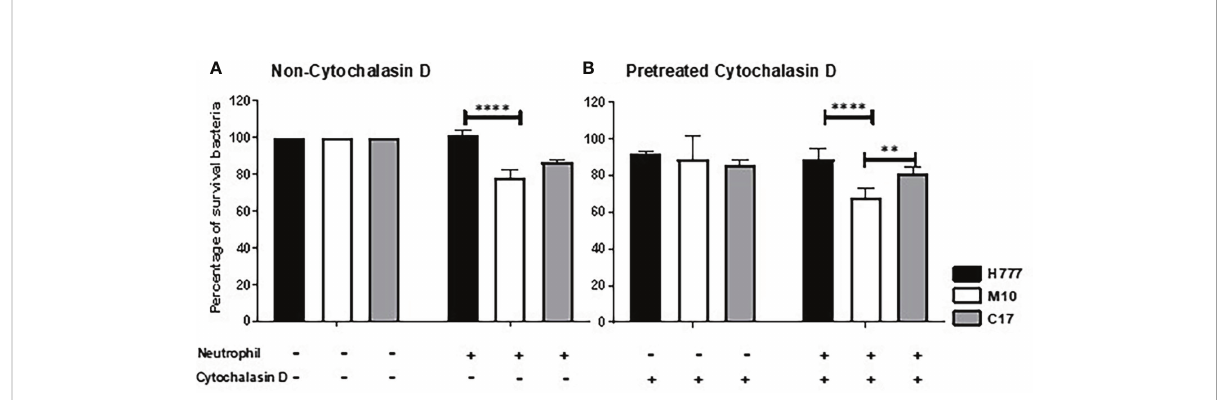
FIGURE 1 Burkholderia pseudomallei H777 signi fi cantly better withstood neutrophil-mediated killing with or without the presence of cytochalasin D than did M10, the strain lacking functional bpsl0618 . The extent of neutrophil-mediated killing was assessed after 90 min co-cultivation of the bacteria with neutrophils untreated (A) or pretreated (B) with cytochalasin D. Percentage of B. pseudomallei cells surviving were determined from 3 independent experiments. Data are represented as mean ± standard deviation. Asterisks denote statistical signi fi cance (** p < 0.01, **** p <